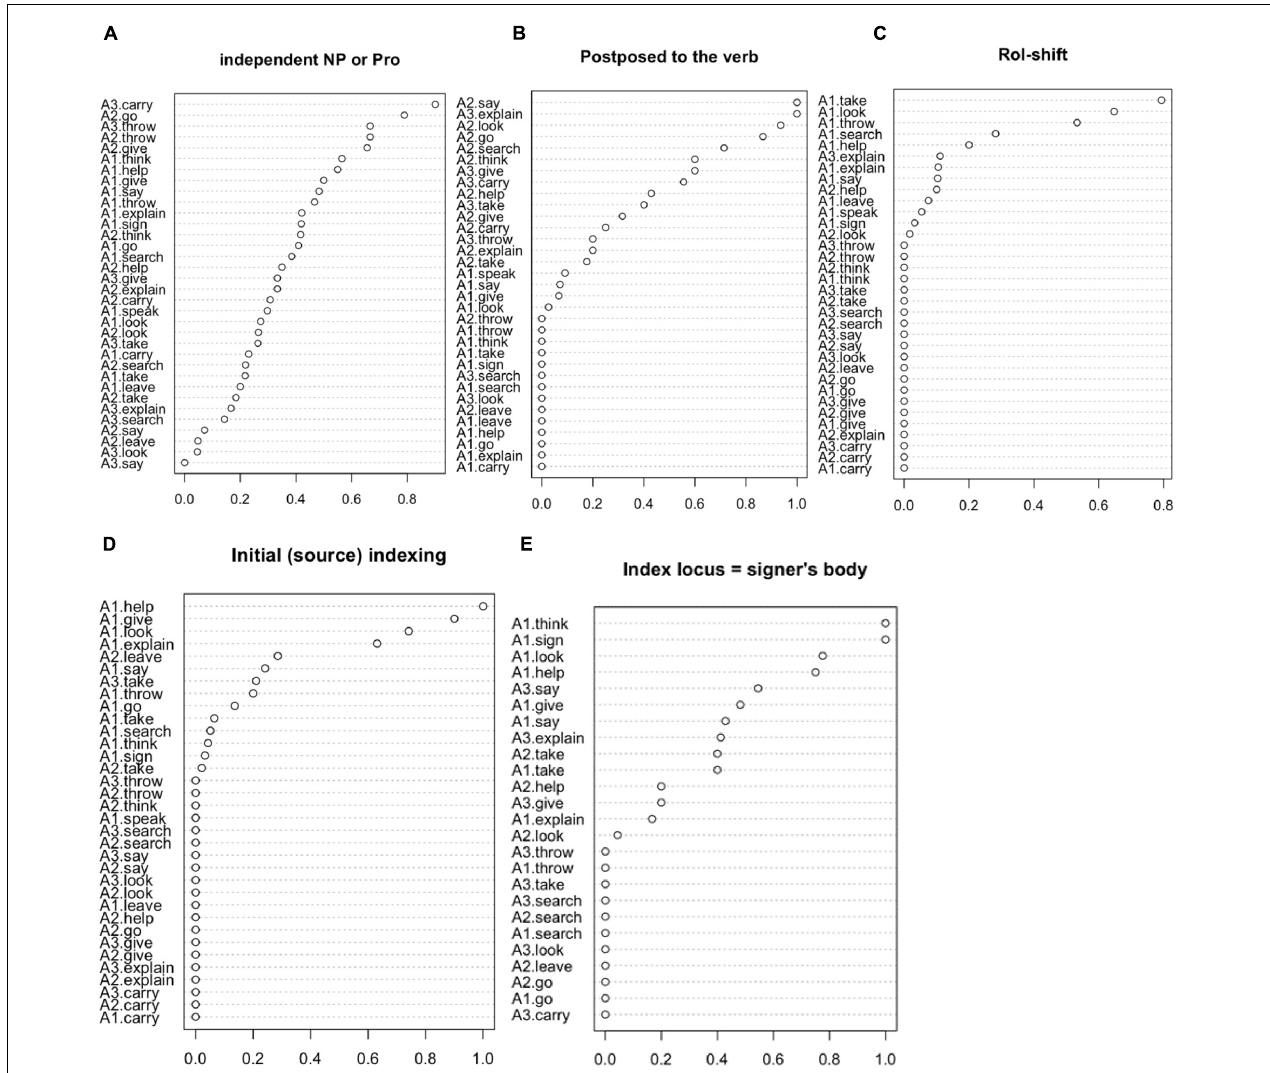
FIGURE 2 | Proportion of arguments expressed according to descriptive values.